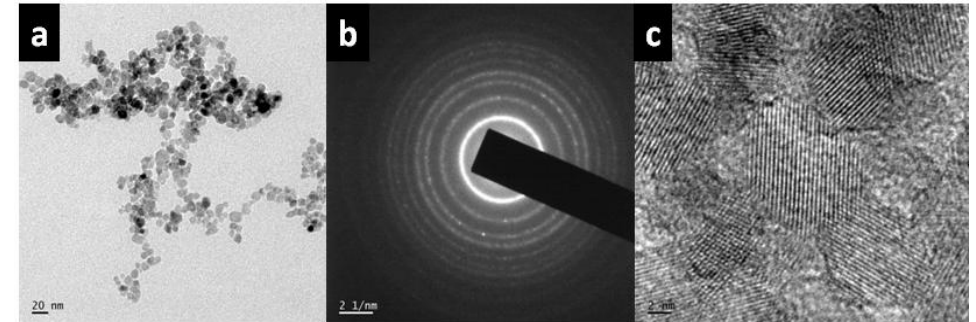
Figure 6. (a) TEM (Transmission Electron Microscopy) image, (b) SAED pattern and (c) HR-TEM (High Resolution TEM) micrograph of TiO 2 nanoparticles.